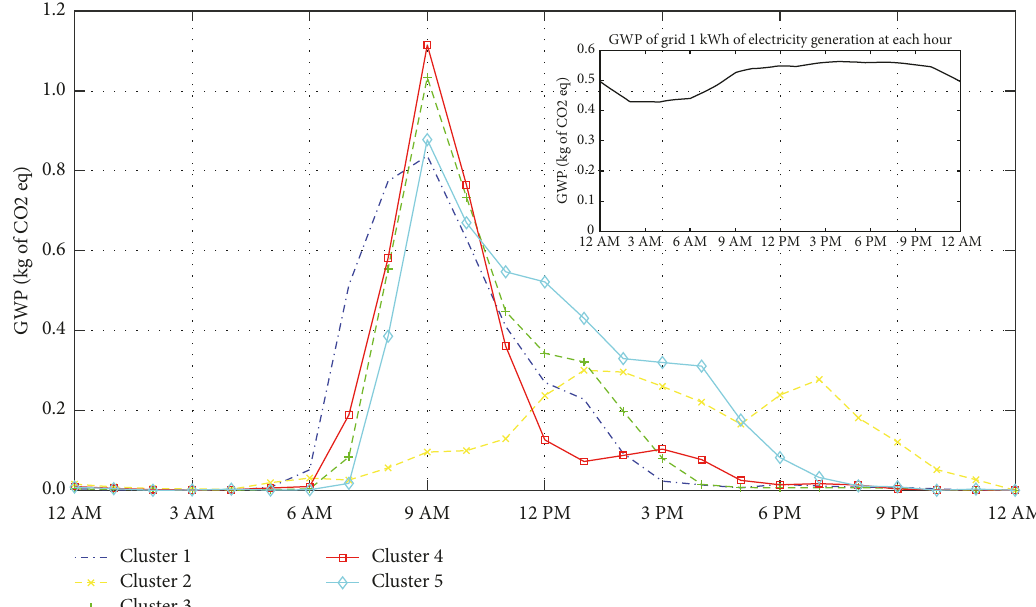
Figure 7: Global warming potential (GWP) in terms of kg of CO 2 eq. for electricity consumed by an average daily profile of respective cluster at each hour and emissions from grid for generation of 1kWh at each